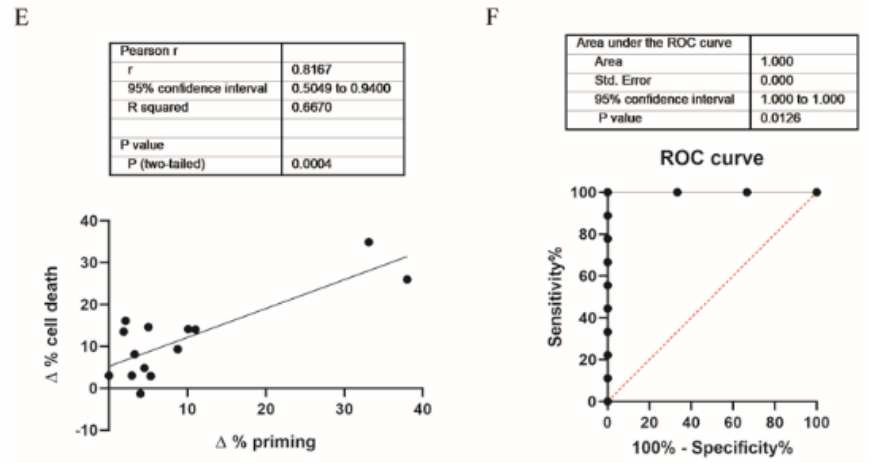
Figure 1. Dynamic BH3 profiling predicts sensitivity to targeted agents in different ER+ breast cancer cell lines. ( A ) Results from the DBP assay after 16 h incubation with different treatments in MDA-MB-415 cells. Results expressed as ∆ % priming represents the increase in priming compared to control cells. ( B ) Cell death results from Annexin V and propidium iodide staining and FACS analysis after 72 h incubation with the targeted agents in MDA-MB-415 cells. Results expressed as ∆ % cell death represents the increase in cell death compared to control cells. ( C ) Results from the DBP assay after 16 h incubation with different treatments in T47D cells. Results expressed as ∆ % priming represents the increase in priming compared to control cells. ( D ) Cell death results from Annexin V and propidium iodide staining and FACS analysis after 72 h incubation with the targeted agents in T47D cells. Results expressed as ∆ % cell death represents the increase in cell death compared to control cells. ( E ) Correlation analysis between Δ % priming and Δ % cell death in MDA-MB-415 and T47D cells. ( F ) Receiver operating characteristic curve analysis. Values indicate mean values ± SEM from at least three independent experiments. ** p < 0.01.